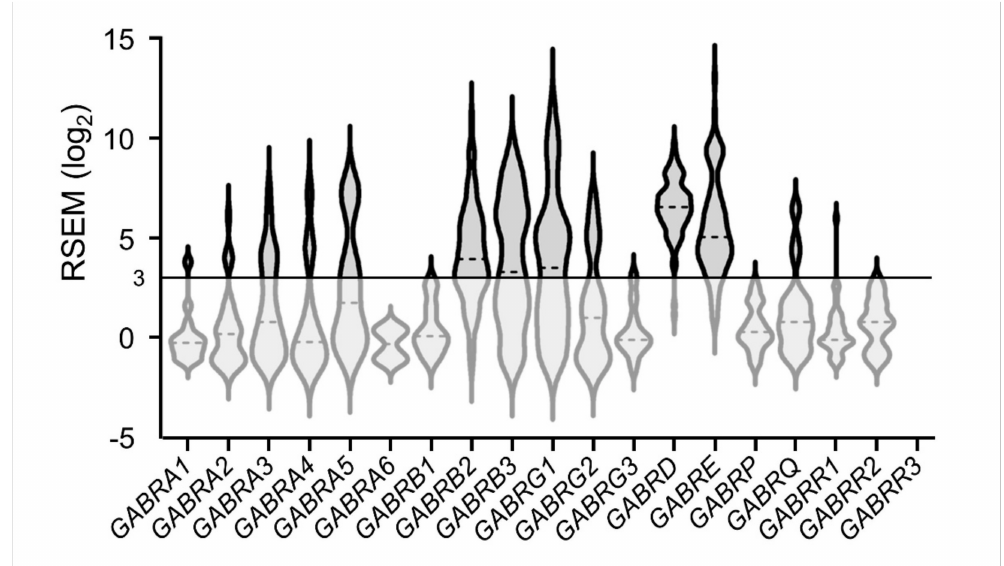
Figure 5. Expression of transcripts encoding GABA A receptor subunits; dotted lines represent median expression levels. Gene names given on the x